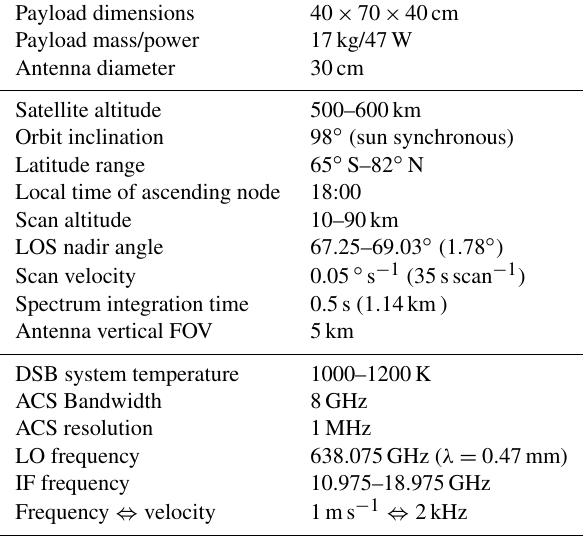
Table 1. Characteristics of the SIW payload and observations. The relationship between tangent height and LOS angle is derived for an Earth radius of 6370km and a satellite altitude of 550km above the